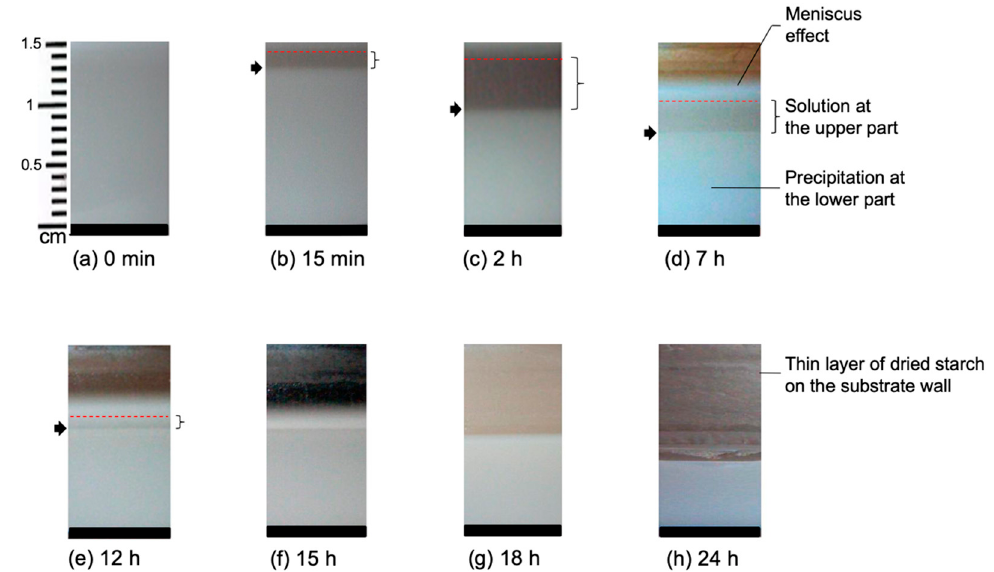
Figure 1. Sample a containing 1% starch in H 2 O at different stages of drying. The evolution time increases from ( a ) 15 min to ( h ) 24 h. The arrow shows the phase separation, whereas the bracket shows the upper solution layer. The different backgrounds in the upper part of the pictures are due to the different light at different times of the day.